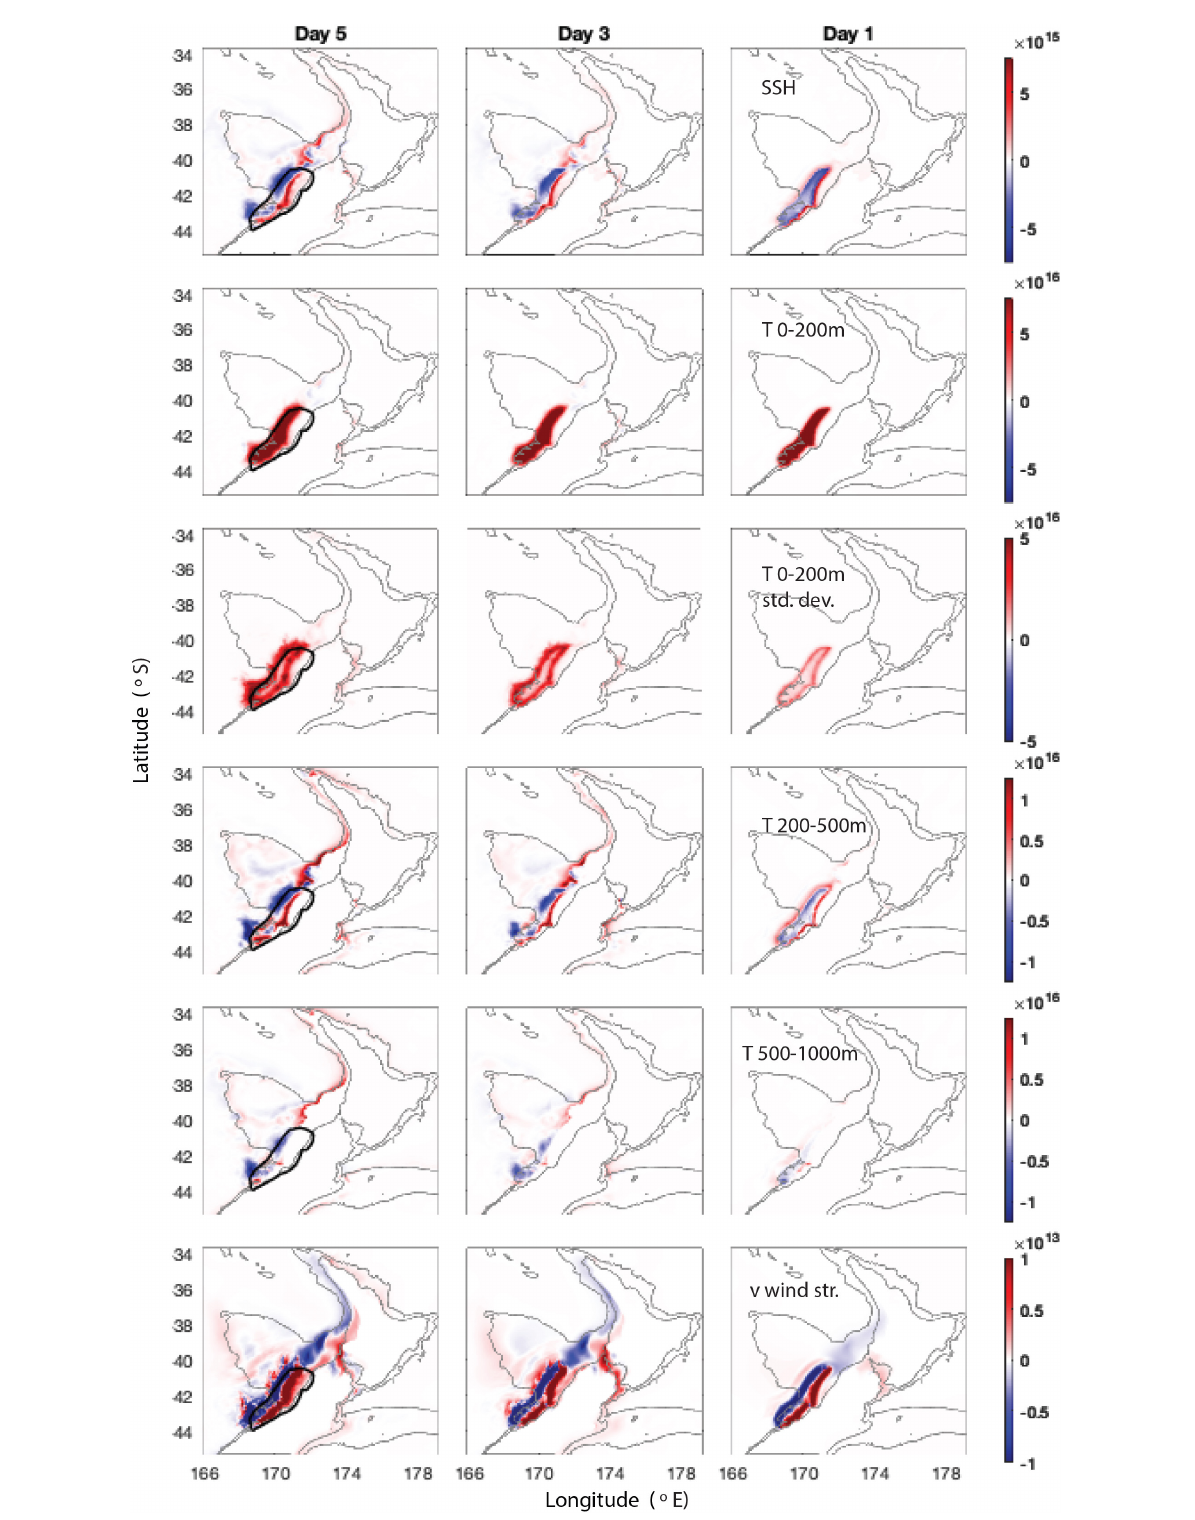
FIGURE14 Ensemble sensitivities for days 5, 3, and 1 leading up to all 34 MHW events in the Hokitika region. (Top to bottom) Mean scaled sensitivity to SSH, mean scaled sensitivity to temperature from 0 to 200 m, standard deviation of scaled sensitivity to temperature from 0 to 200 m, mean scaled sensitivity to temperature from 200 to 500 m, mean scaled sensitivity to temperature from 500 to 1,000 m, and mean scaled sensitivity to surface meridional wind stress. Sensitivities are scaled by the 5-day standard deviations for the days leading up to the MHWs, averaged in quadrature. Gray lines show the 100 and 1,000 m bathymetry